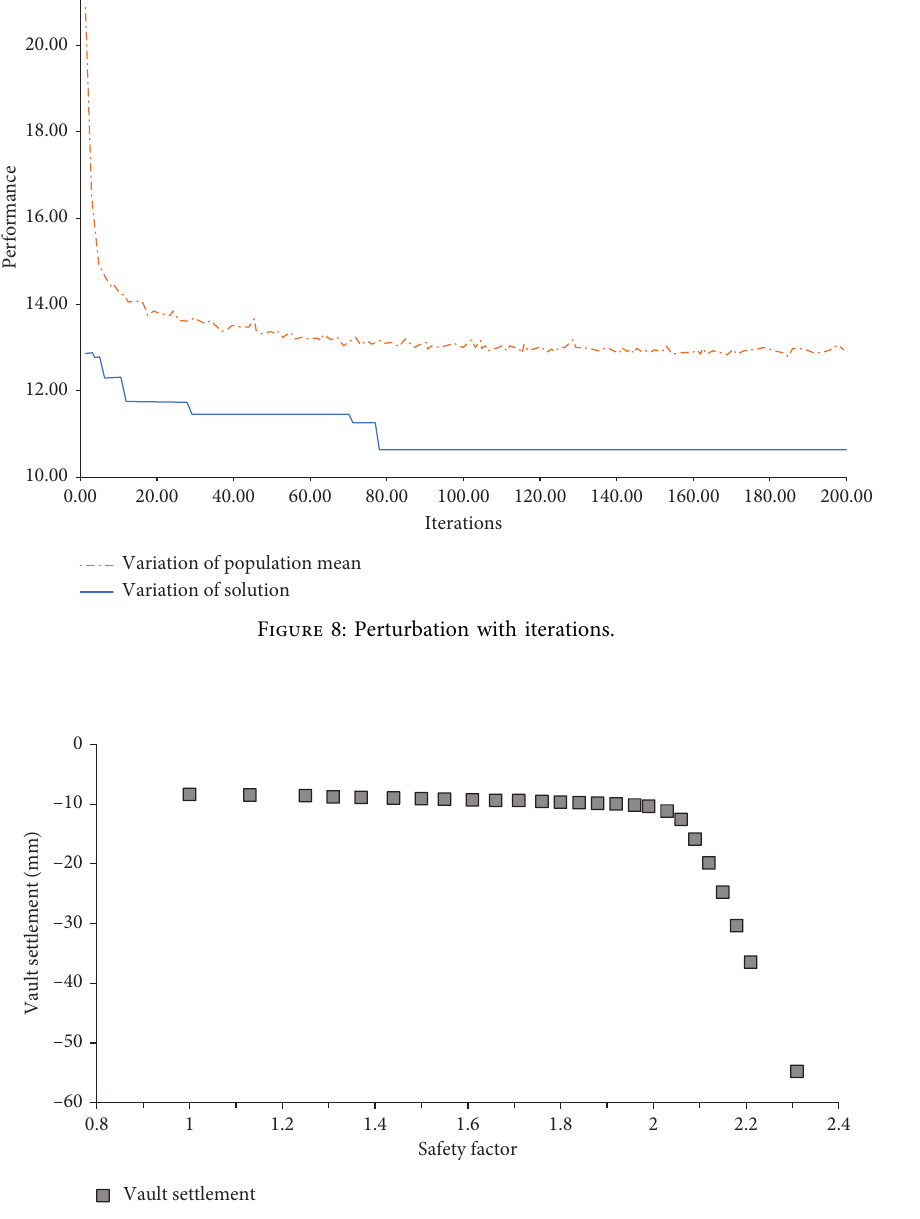
Figure 8: Perturbation with iterations.